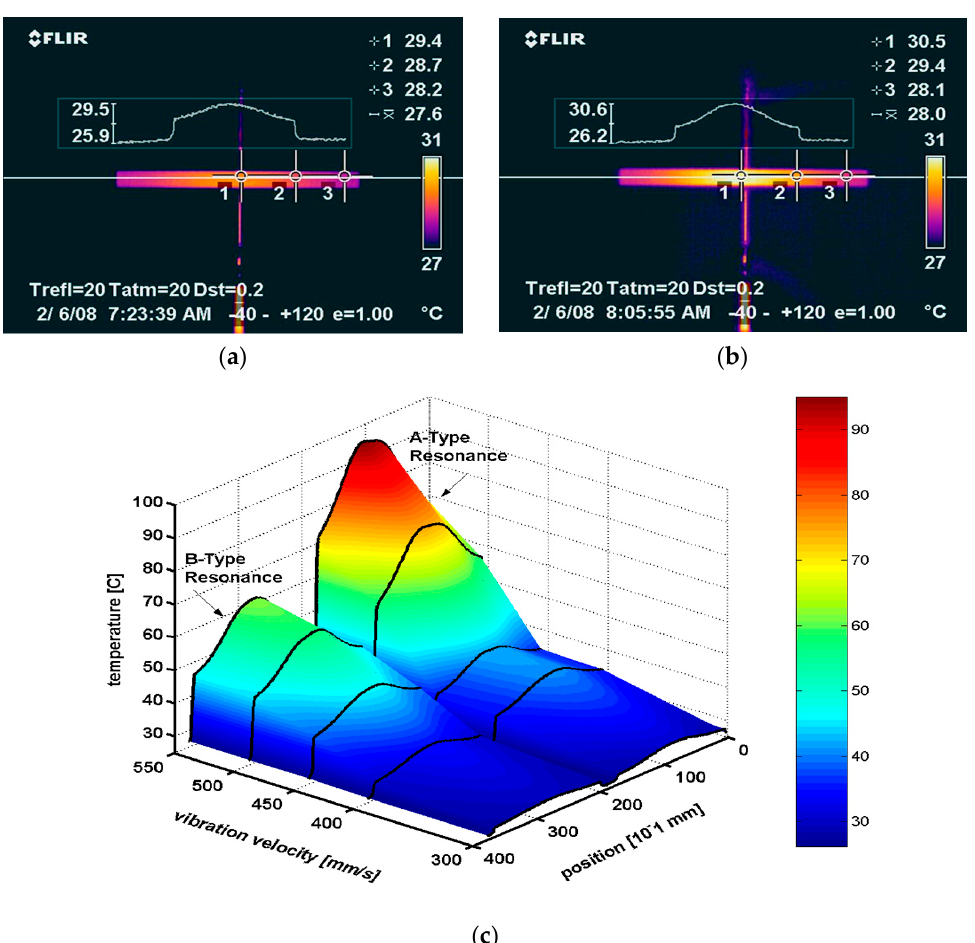
Figure 18. Temperature variations in a PZT-based plate specimen observed with a pyroelectric infrared camera, when driven at the antiresoance ( a ) and resonance frequency ( b ); ( c ) numerical temperature profile for the A- and B-type resonance modes.